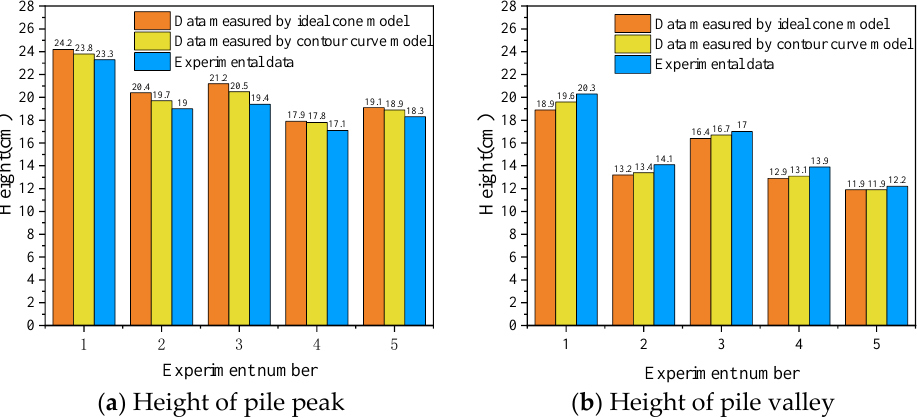
Figure 12. Comparison of experimental measurement data and algorithm modeling data.